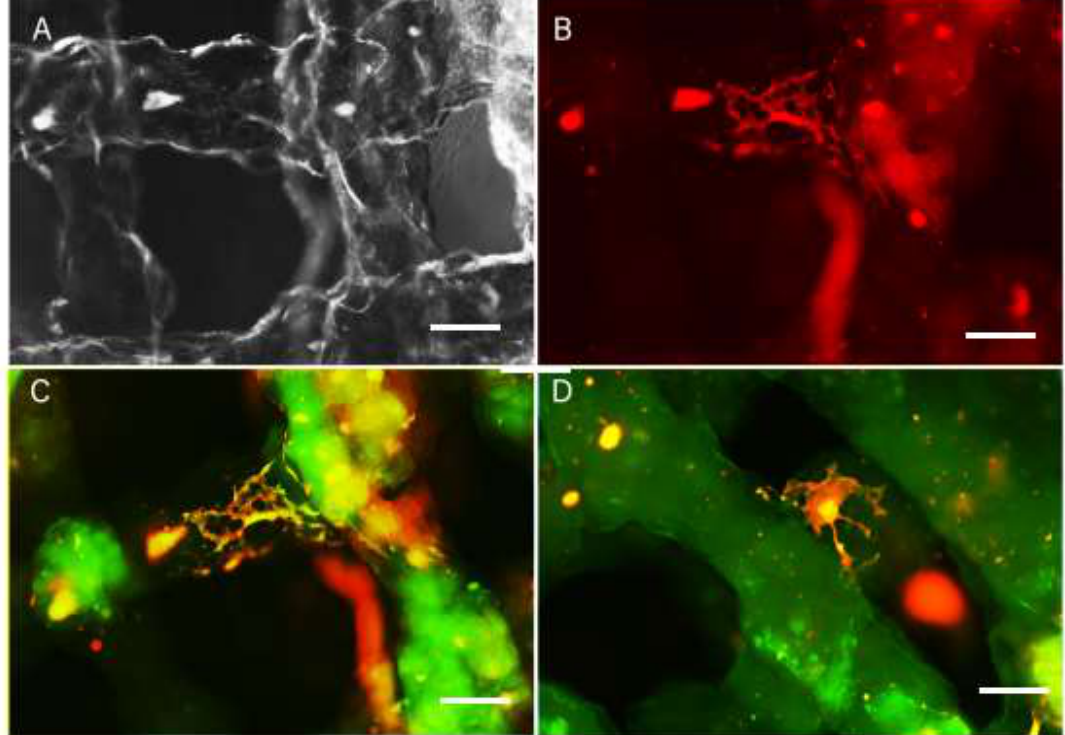
Figure 6. Live images of scaffolds ( A , B ) and fixed scaffolds 3 weeks after printing. GFAP staining (green) reveals glial cells differentiated in the scaffold ( C ) and bTUB staining ( D ) reveals neurons differentiated in the scaffold, with the cell bodies located inside the scaffold and on the surface of the printed structure. Scale bar: A,B,C,D = 10 microne.